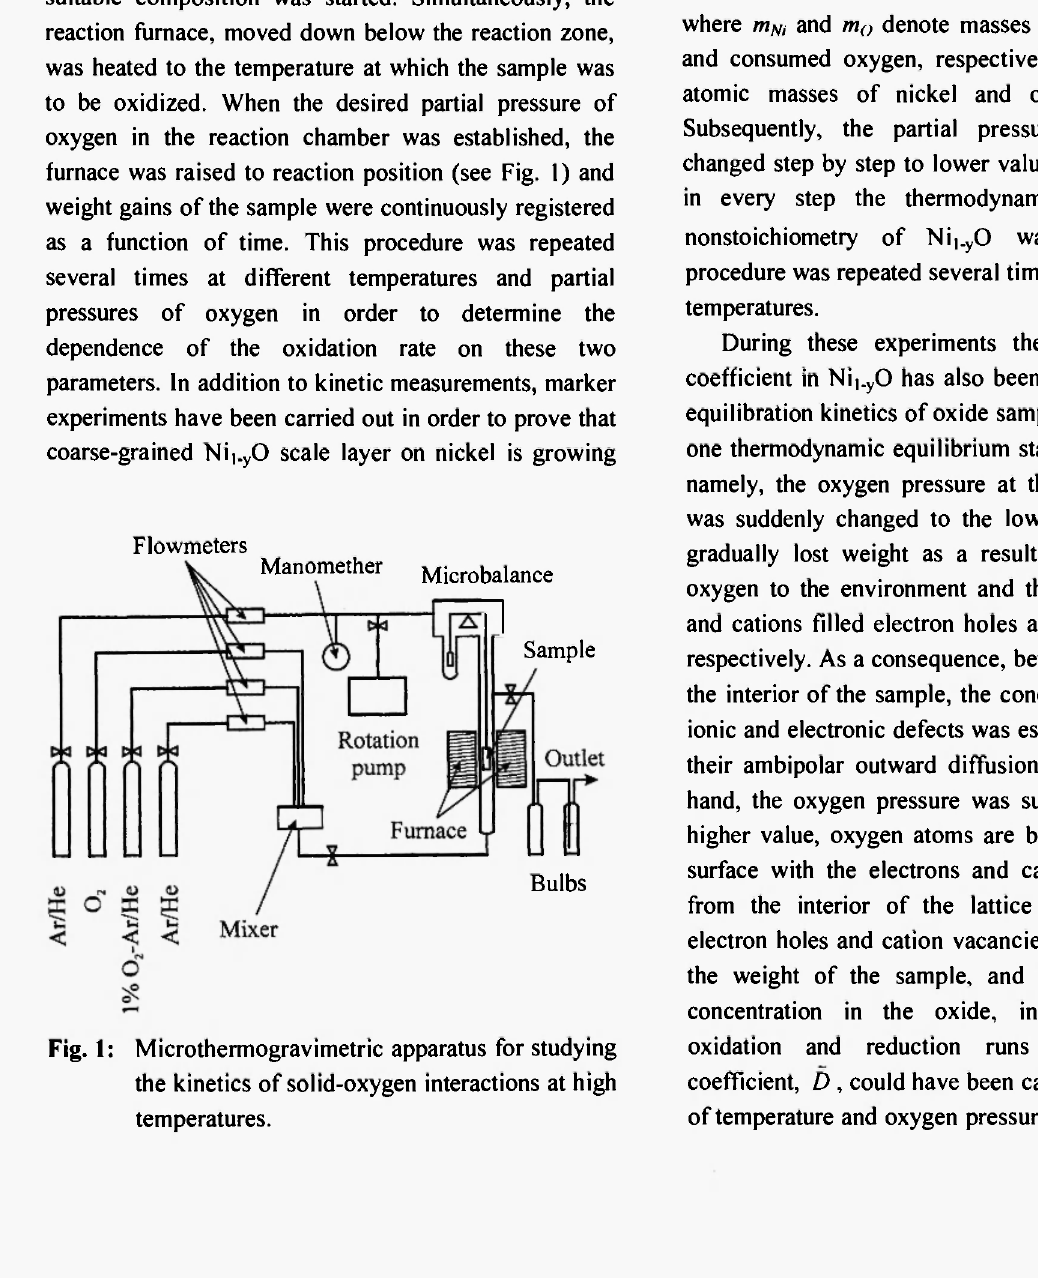
Fig. 1: Microthermogravimetric apparatus for studying the kinetics of solid-oxygen interactions at high